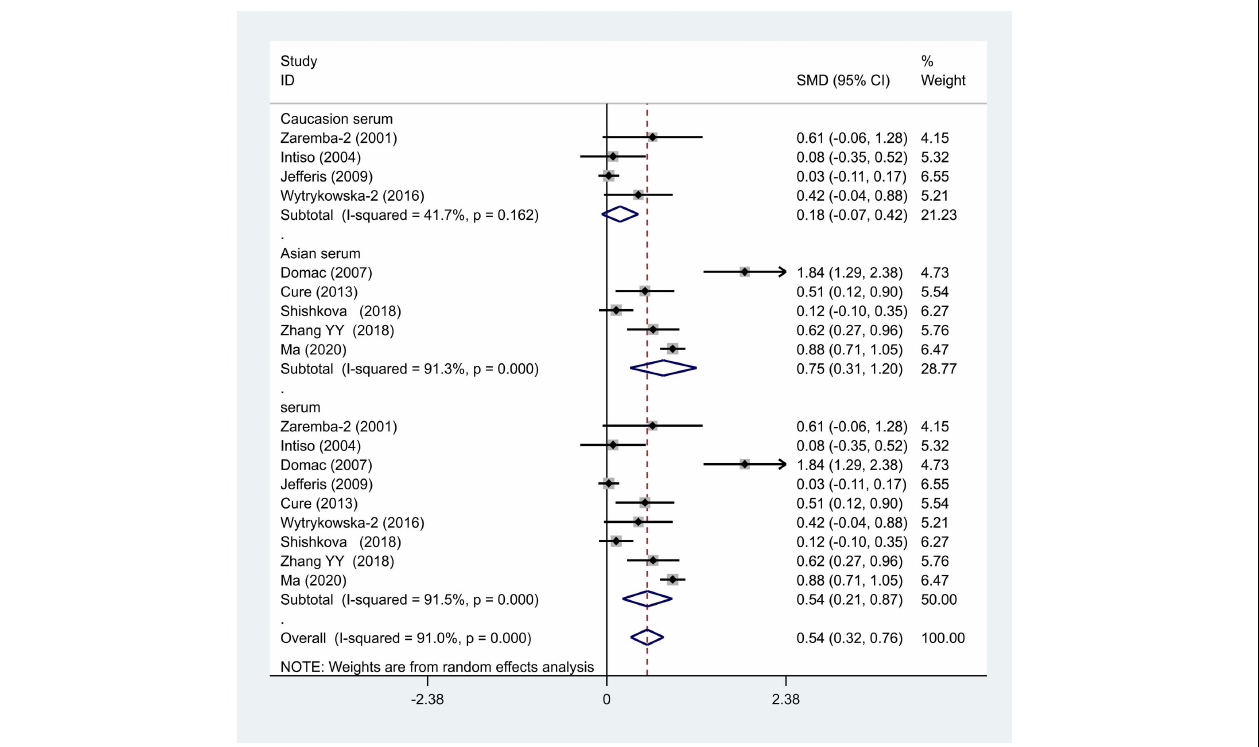
FIGURE 7 | Results of meta-analysis for the level of TNF- α in the Asian and Caucasian populations, respectively.